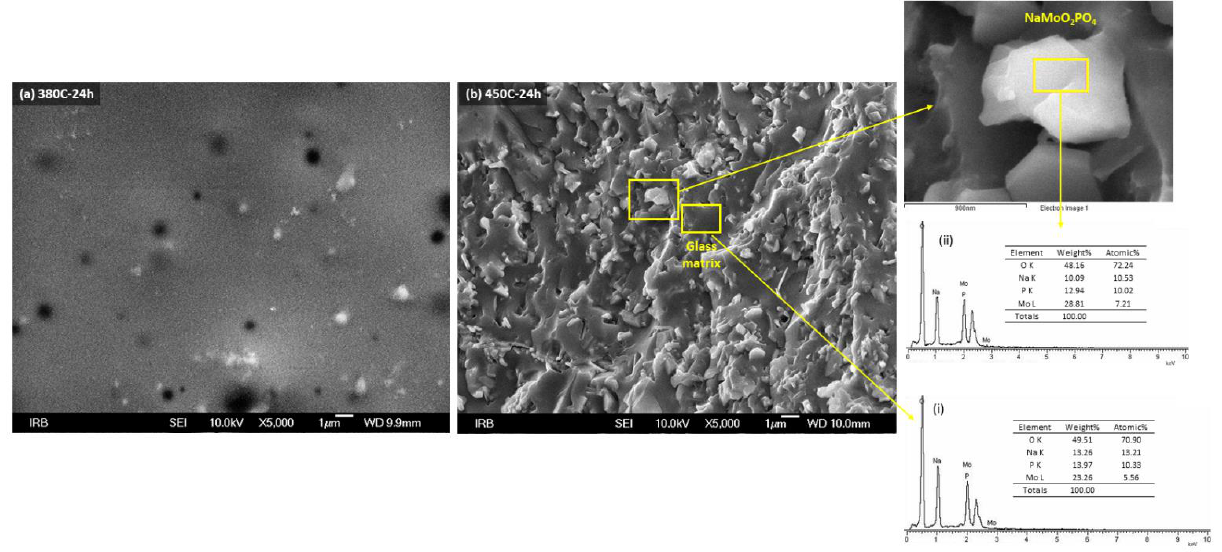
Figure 2. SEM micrographs of samples prepared at ( a ) 380 °C for 24 h and ( b ) 450 °C for 24 h, and EDS spectra from selected areas of 450 C-24 h sample.